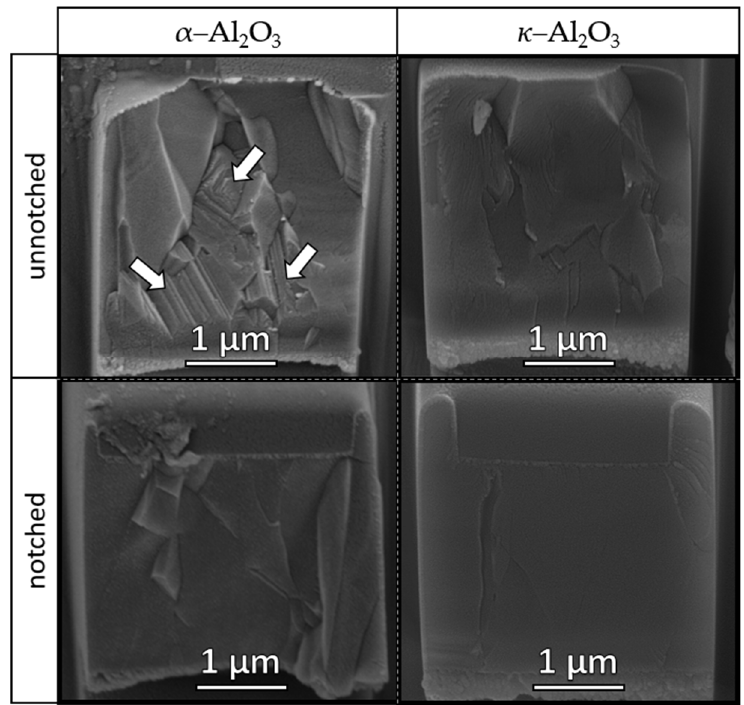
Figure 6. Post-mortem fracture cross-sections of the unnotched and notched micro-cantilevers. The arrows in the cross-section of the unnotched α –Al 2 O 3 mark step-like fracture grains.